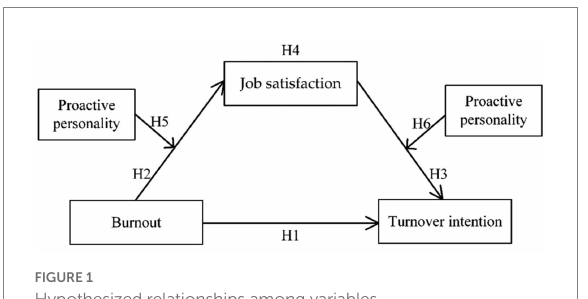
FIGURE 1 Hypothesized relationships among